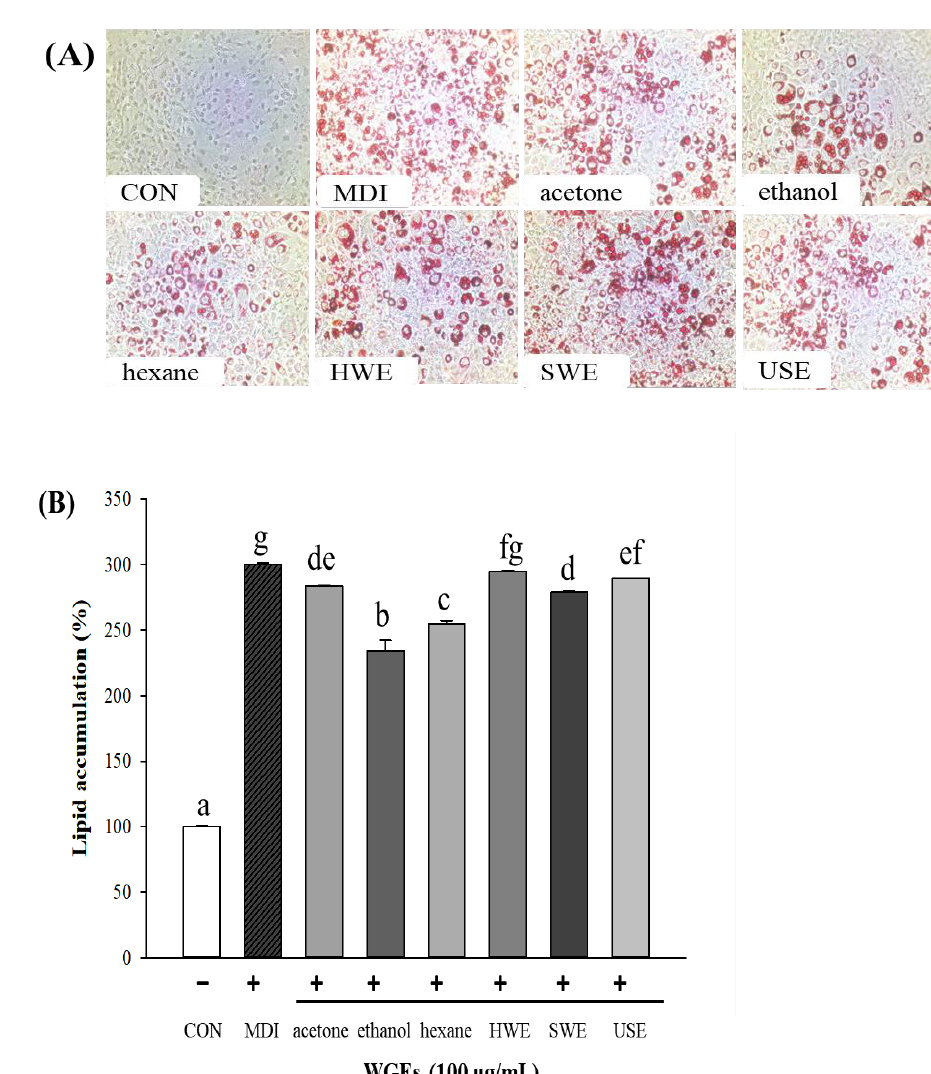
Figure 5. Effect of wheat germ extracts (WGEs) on cellular lipid accumulation in 3T3-L1 adipocytes. ( A ) The morphology of stained intracellular lipid droplets by Oil Red O staining at 400× magnifica- tion. ( B ) The content of cellular lipid accumulation stained by Oil Red O. Different letters indicate significant differences at p < 0.05, determined by Duncan’s multiple range test. CON, control; MDI (methylisobutylxanthine, dexamethasone, insulin; differentiated media); HWE, hot water extract; SWE, subcritical water extract; UWE, ultrasonic water extract.